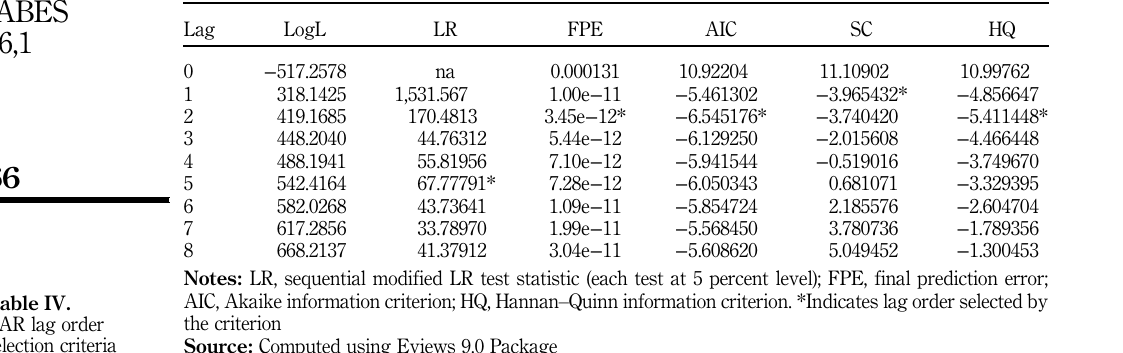
selection criteria